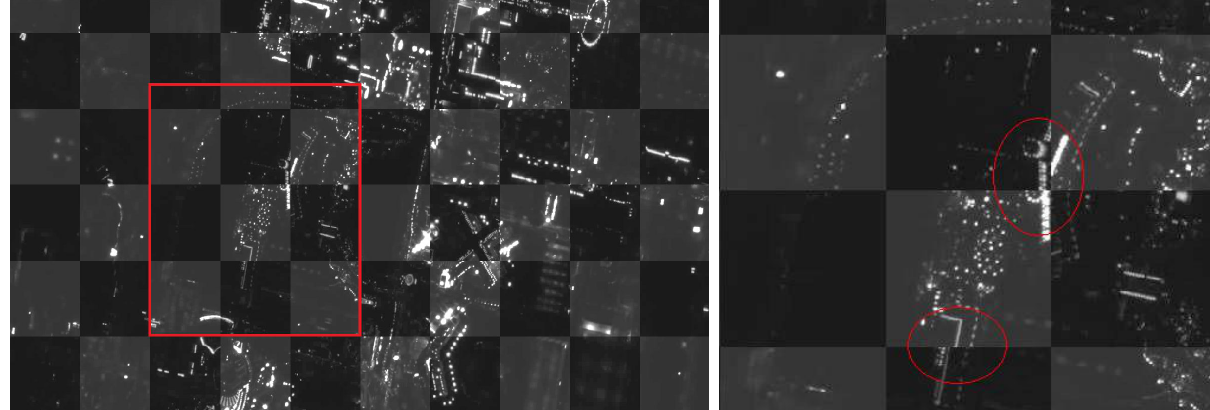
(e) Results from the descriptor-based registration in the Las Vegas-night video dataset (f) zoom-in area ( e.g., with certain errors inside the red circles) Figure 5: Registration results after the application of the descriptor-based